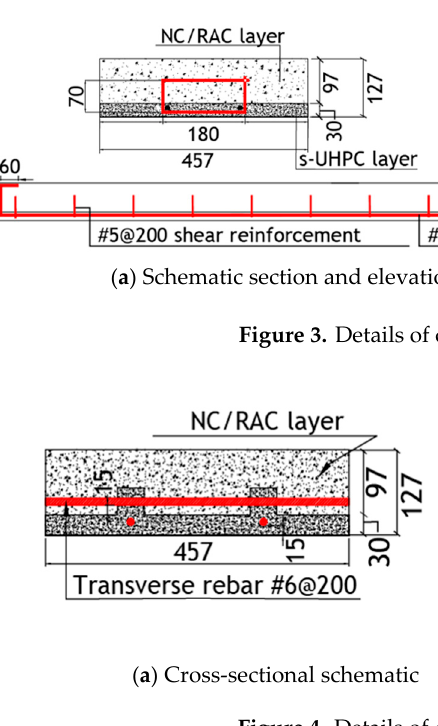
Figure 2. Details of deck type A (units in mm).